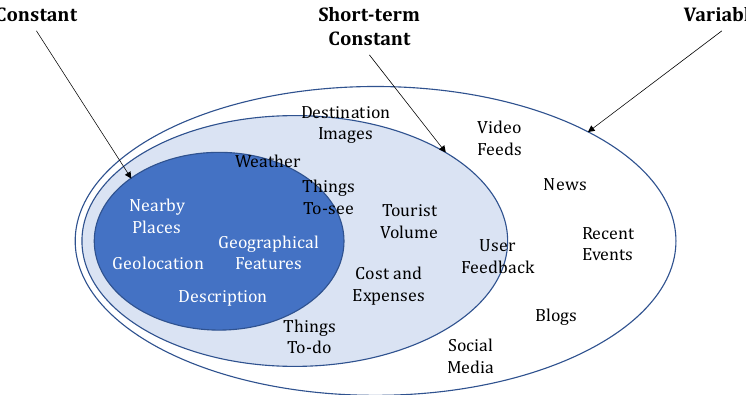
Figure 2. Modeling of information requirements from big data sources for TRS.